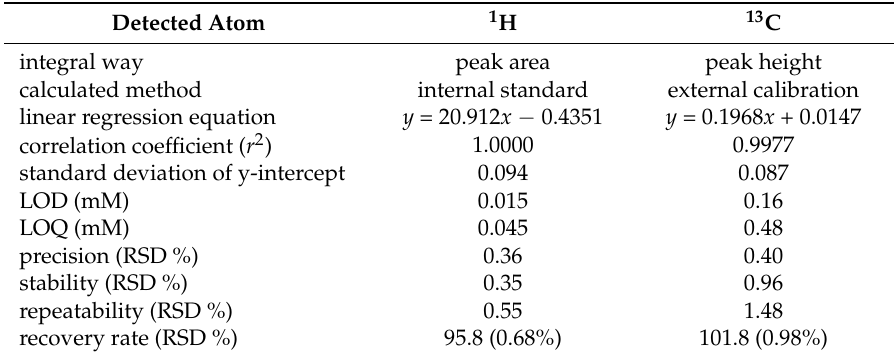
Table 4. Validation results for NMR techniques of glycerol ( n =